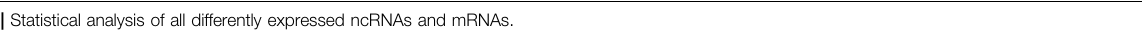
TABLE 2 | Statistical analysis of all differently expressed ncRNAs and mRNAs. DE RNAs Total no.